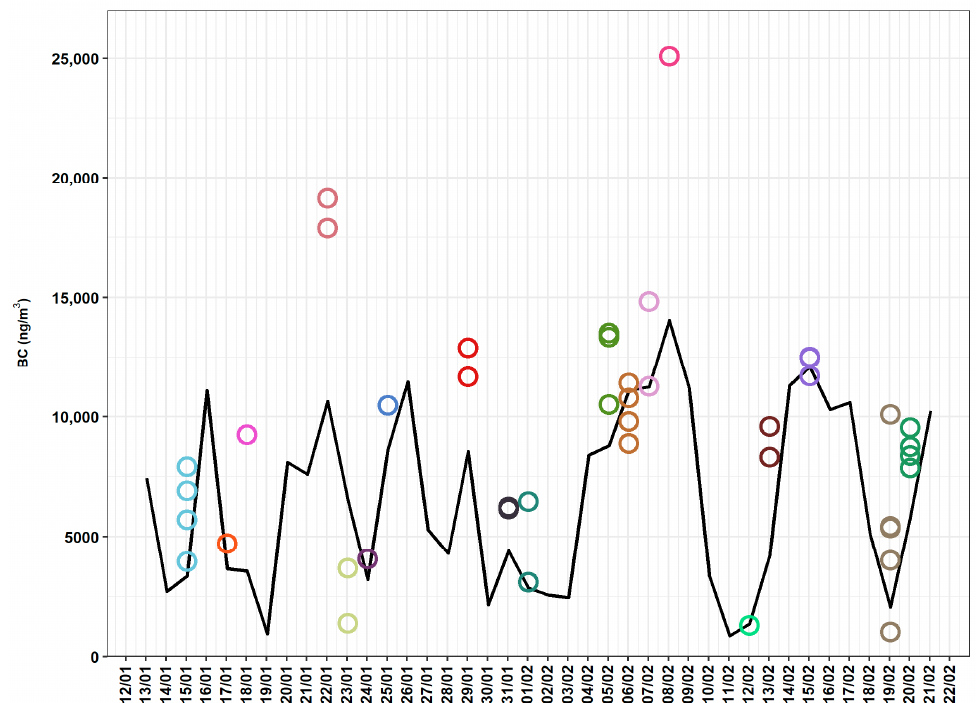
Figure 2. Average MRH BC concentrations measured at an urban background reference site (black line) and average home-to-school commuting personal exposure values (circles) during the 2019 personal exposure monitoring campaign. The colors of the circles correspond to the different days of monitoring.